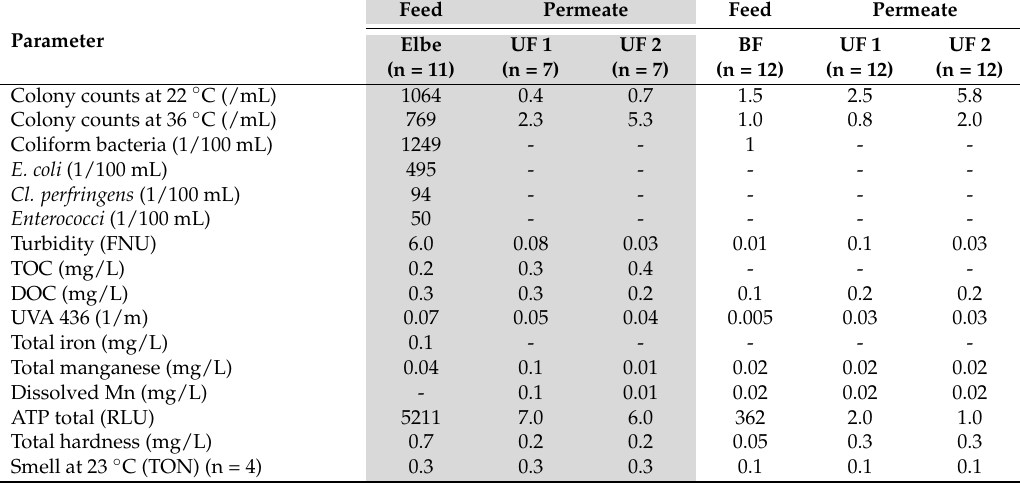
Table A1. The standard deviation of the laboratory results for the UF membrane plant, convergence